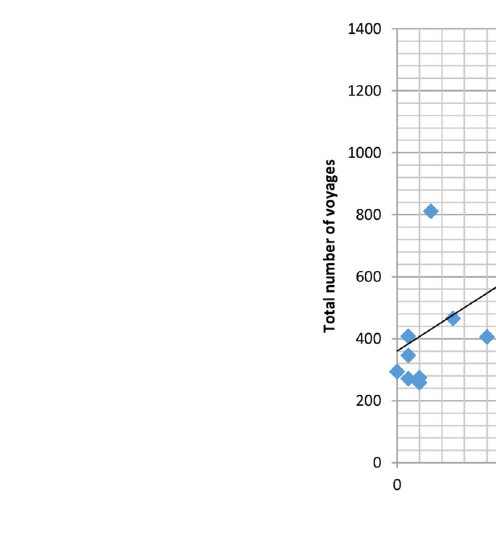
FIGURE 8 Linear relationship between cruise policies and total voyages.